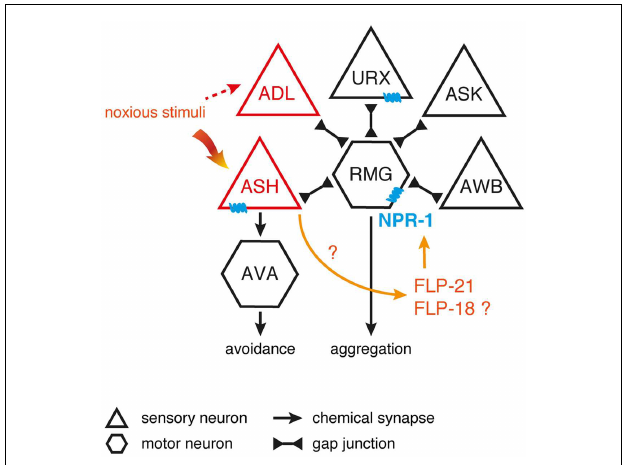
FIGURE 3 | FLP signaling suppresses egg-laying in unsuitable environments . BAG neurons release FLP-17 neuropeptides in response to unfavorable conditions.These peptides are able to activate the EGL-6 receptor on HSN motor neurons, hereby inhibiting egg-laying. Release of FLP-10 by the vulva and spermatheca along with subsequent EGL-6 signaling further inhibits egg-laying, with the exact triggering stimuli still uncharacterized. Under unfavorable conditions, cholinergic signals (ACh) may be independently invoked by other sensory circuits to synergistically inhibit egg-laying [adapted from Ref. (53,